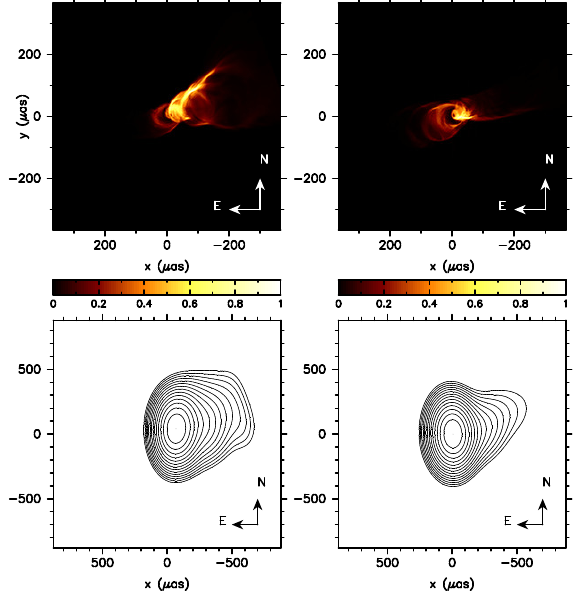
Figure 3. Top panels : Intensity maps ( λ = 7 mm) for a viewing angle of 20 ◦ ( left ) and 160 ◦ ( right ) from a time-dependent model of a radiatively inefficient accretion flow onto a BH based on a fully 3D GRMHD simulation and scaled to the M 87 disc/BH/jet system. Bottom panels: Contour maps of the model convolved with a telescope beam to simulate current observations of M 87. For details about the numerical simulation as well as the emission model and the electron distribution